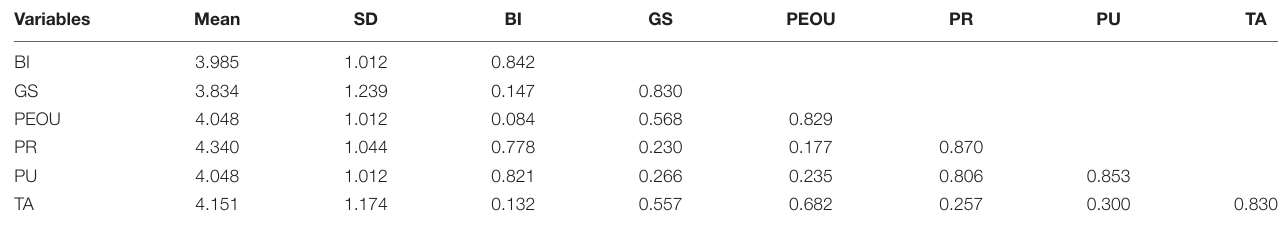
TABLE 3 | Inter-construct correlation and discriminant